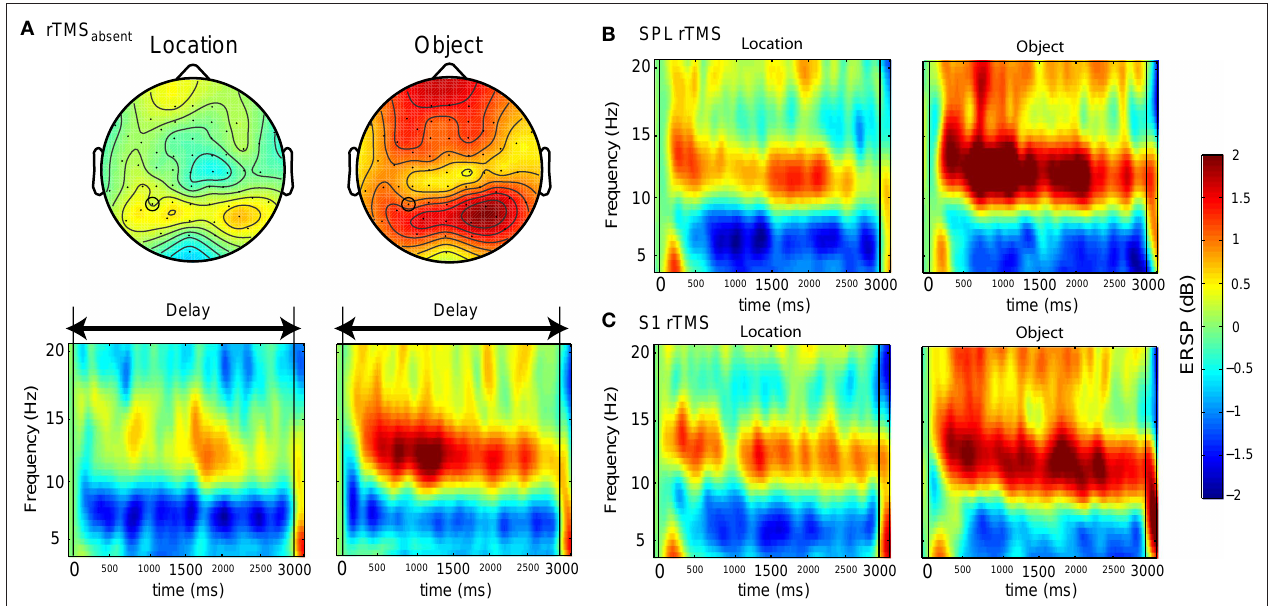
power at 4–8 Hz associated with the onset of the stimulation train. However, compared to the rTMS trials, there was no signifi cant change in power absent within the alpha-band range in rTMS trials. On the plots, 0 ms indicates the present onset of the 3-s delay period. Time-frequency plots are derived from data obtained at electrode P3, the electrode closest to the SPL TMS target. Topographic plots in (A) represent the mean alpha-band power over the 3-s delay period during rTMS trials. absent